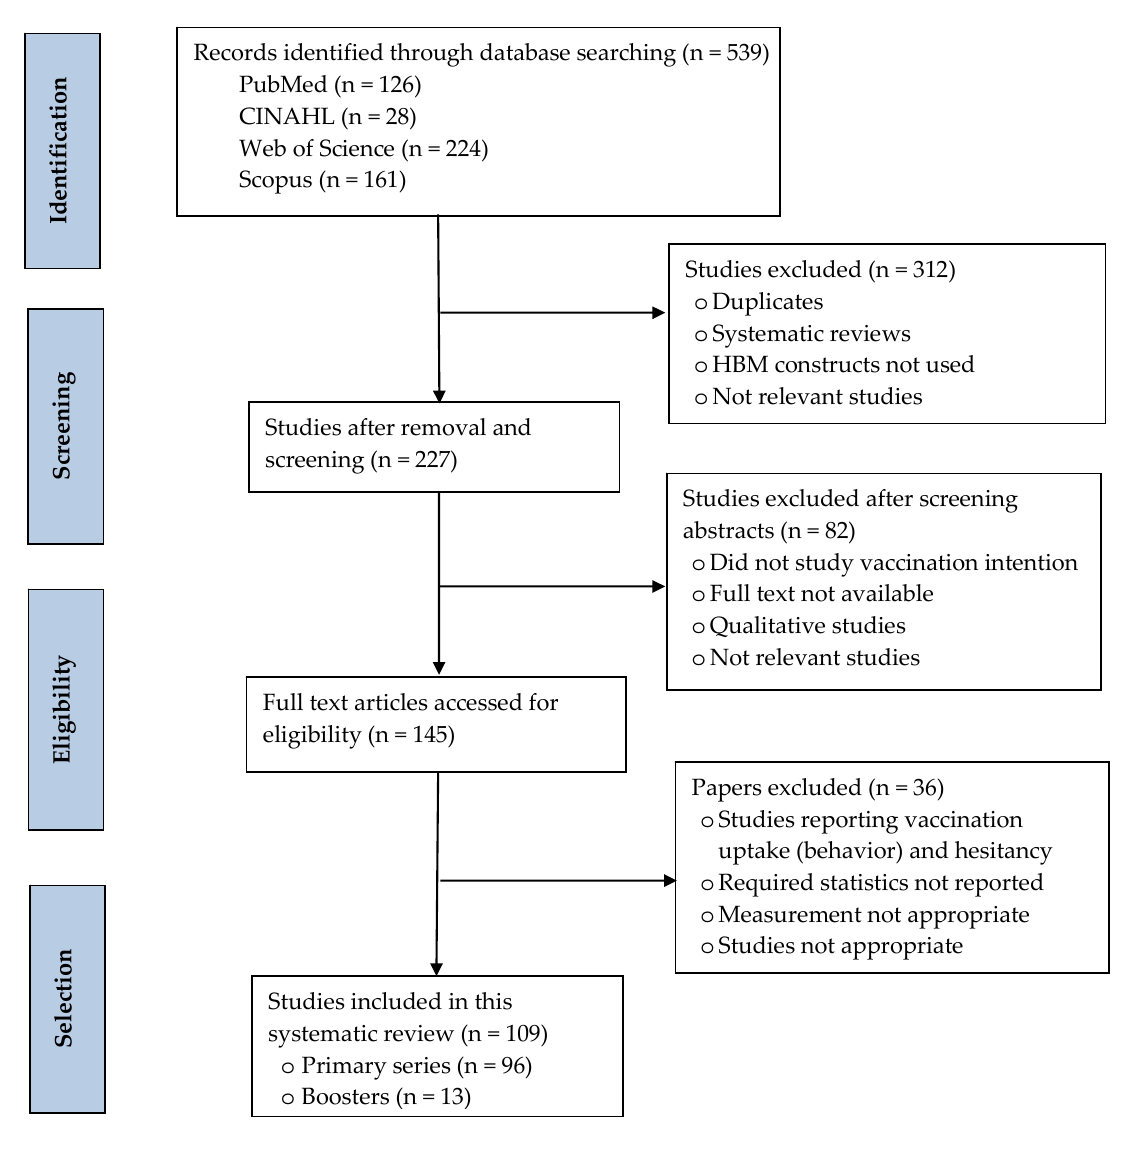
Figure 1. PRISMA fl ow diagram illustrating literature search. Figure 1. PRISMA flow diagram illustrating literature